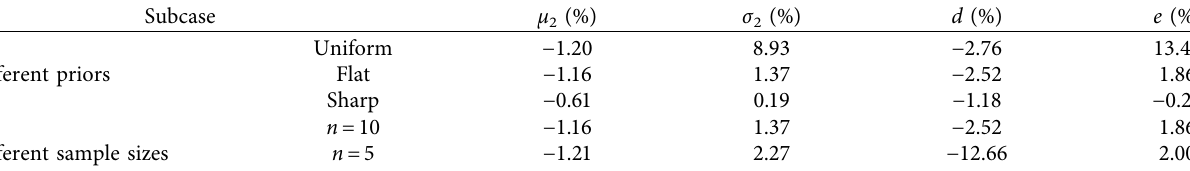
Table 3: Identification errors of the hyperparameters for aleatory uncertain